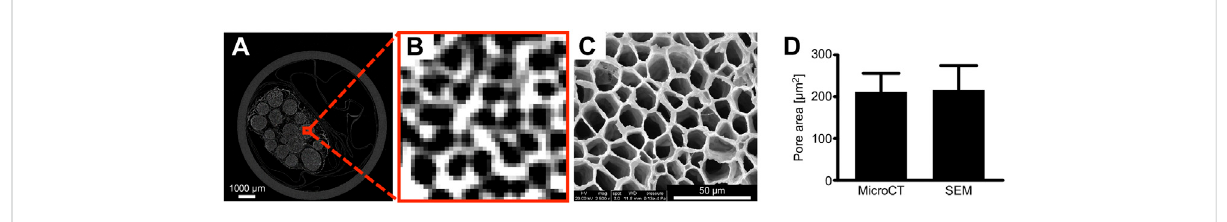
FIGURE 2 Human peripheral nerve Micro-CT images. Compared with SEM, micro-CT images can clearly distinguish the endoneurium microstructure. The measurement area of the pore compared with SEM showed that micro-CT 2D images are authentic. (A) Micro-CT images of the nerves. (B) Micro-CT images of the endoneurium. (C) SEM images. (D) Comparison of the pore areas. n = 10; the scale bars represent 1,000 μ m and 50 μ